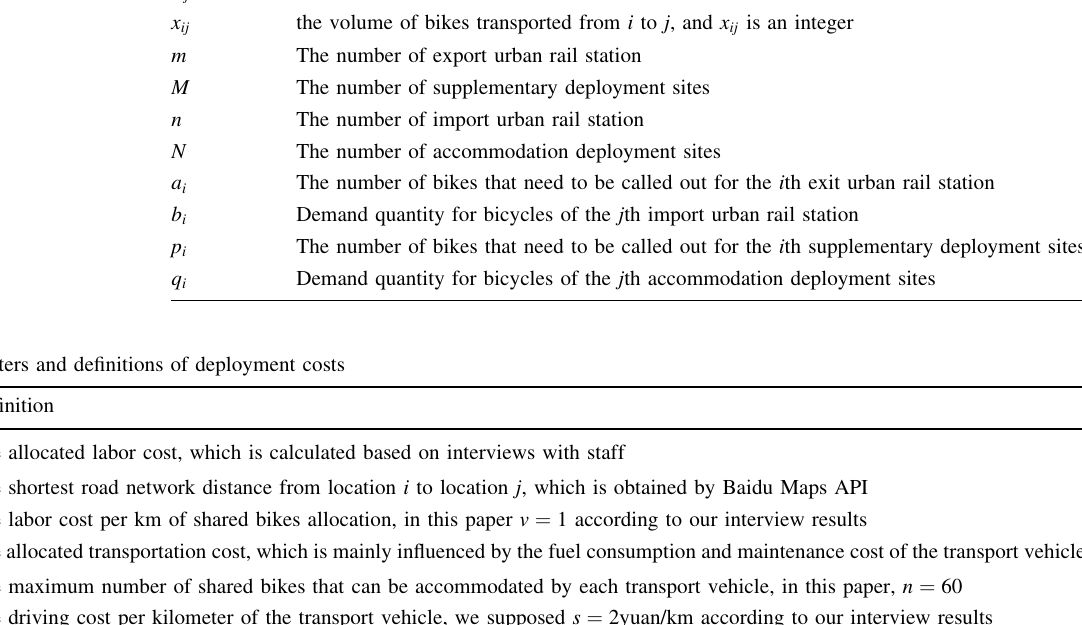
Table 1 Model parameters and definitions